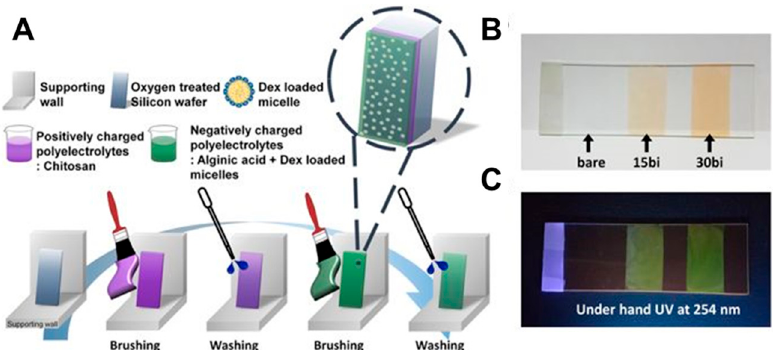
Figure 3. ( A ) Schematic illustration of the brushing layer-by-layer (LbL) self-assembly process on a flat substrate. Photographs of the (PAH-FITC / PAA) n (n = number of bilayers) multilayer films prepared by brushing LbL on a glass slide under ( B ) visible light and ( C ) ultraviolet (UV) light ( λ = 254) (Figure 3A is representing brushing LbL process, and it was drawn by K.P.). Reproduced from Kyungtae et al. (2018) [71] with permission (Copyright © Springer Nature 2018). PAH, poly(allylamine hydrochloride); PAA, poly(acrylic acid).